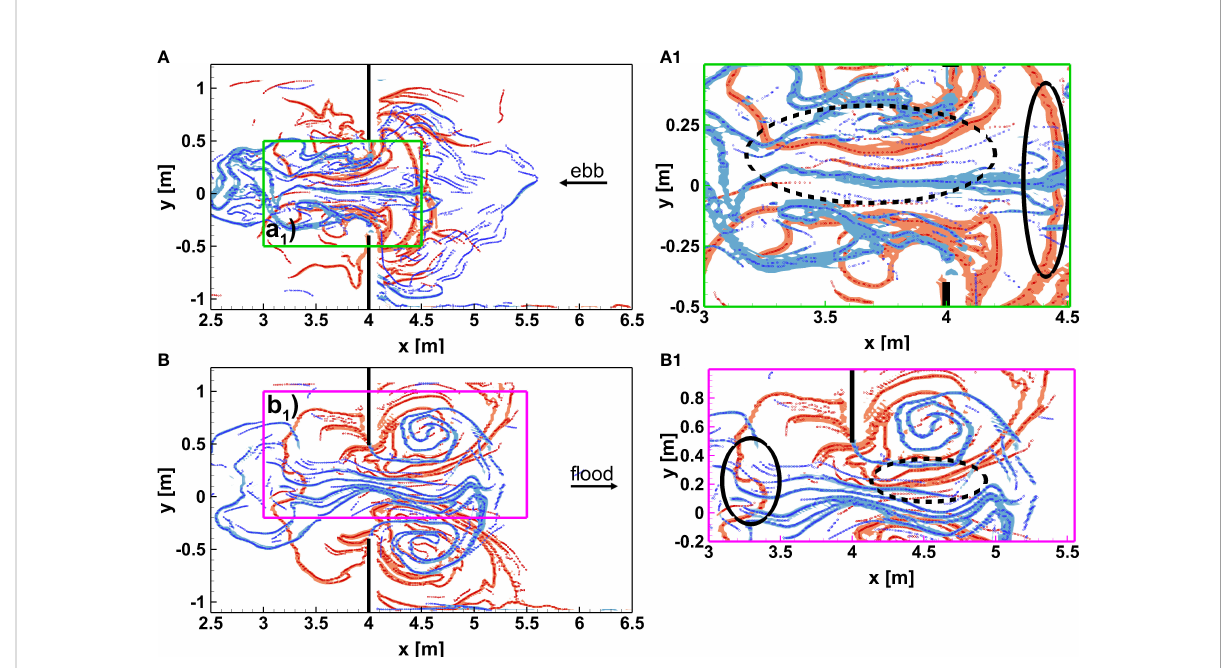
FIGURE 5 Ridges in superposition of forward (red) and backward (blue) integration of FTLE fi eld: Experiment 24. Panel (A) ebb phase; panel a1) focus of shear (dashed oval) and barrier (solid oval) structures. Panel (B) fl ood phase; panel b1) focus of shear (dashed oval) and barrier (solid oval)